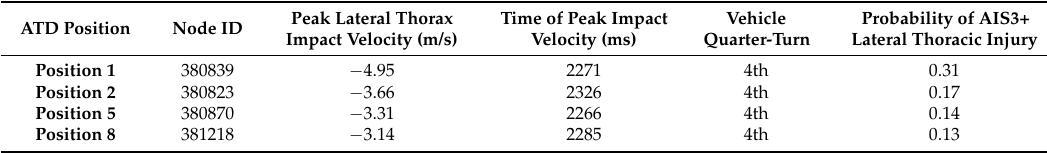
Table 10. Lateral thorax impact